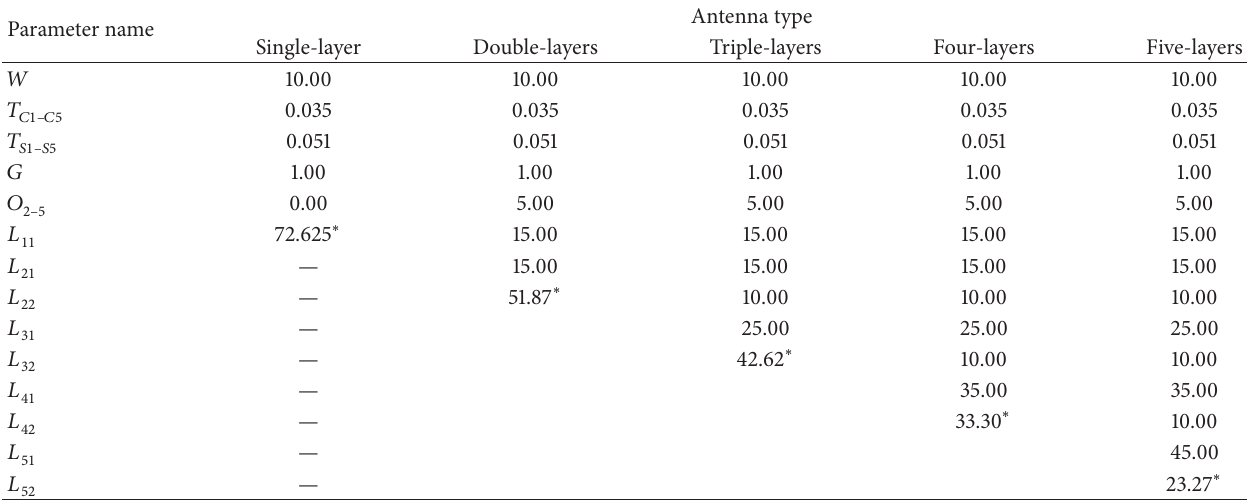
Table 1: The dimension parameters of multilayer strip dipole antenna